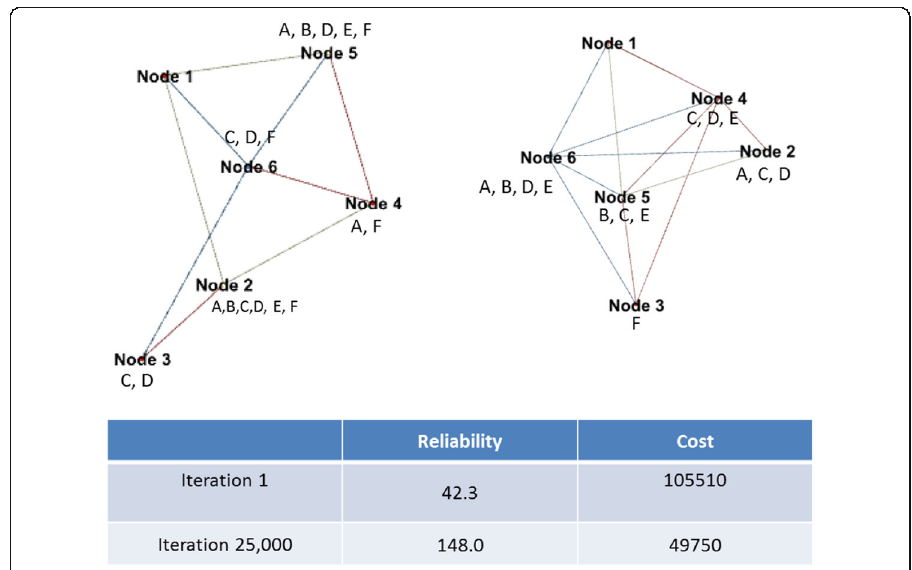
Fig. 5 Example evolution of network configuration